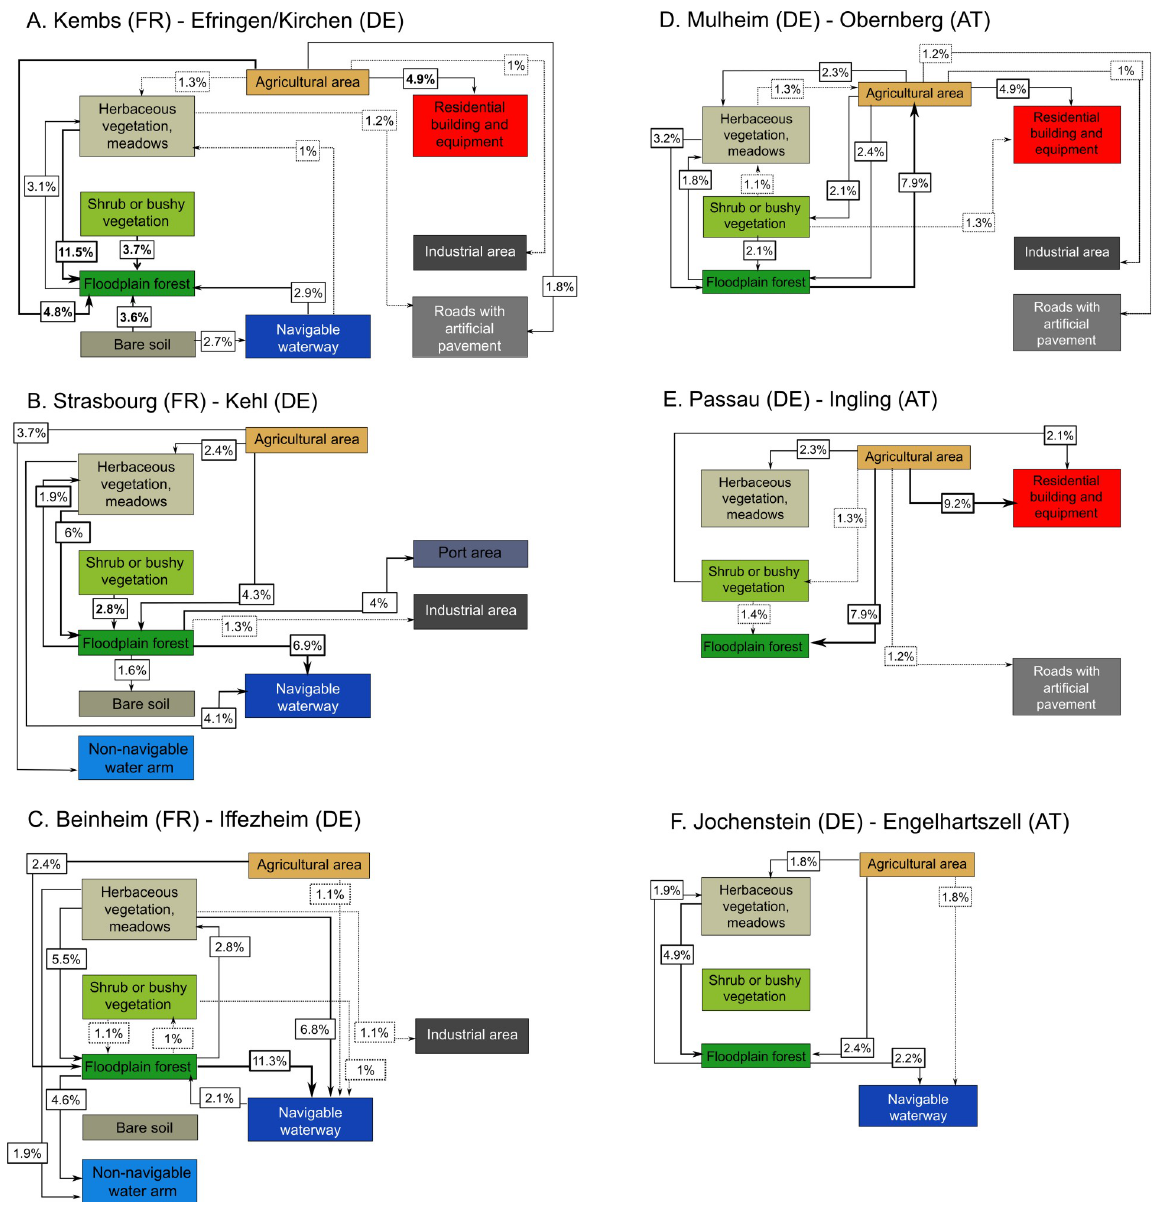
Fig 4. Graphical visualization of global transition matrices covering the 1950s and 2010s for each study site and both regions. A-C = Upper Rhine, D-F = Inn-Danube. The colours of each box are in accordance with the land cover types in Fig 2.